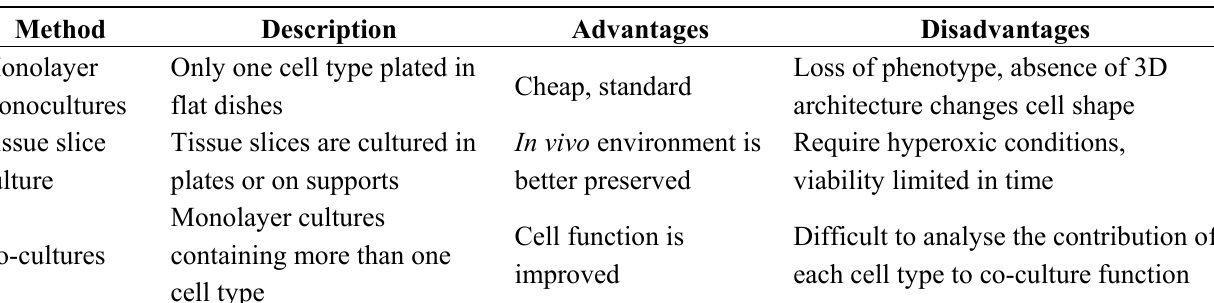
Table 1. The simplest in vitro models.